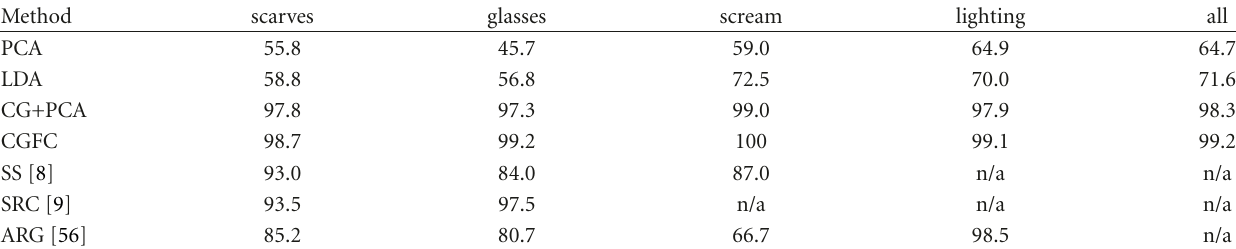
Table 7: Rank one recognition rates (in %) obtained on the five probe sets of the AR database.